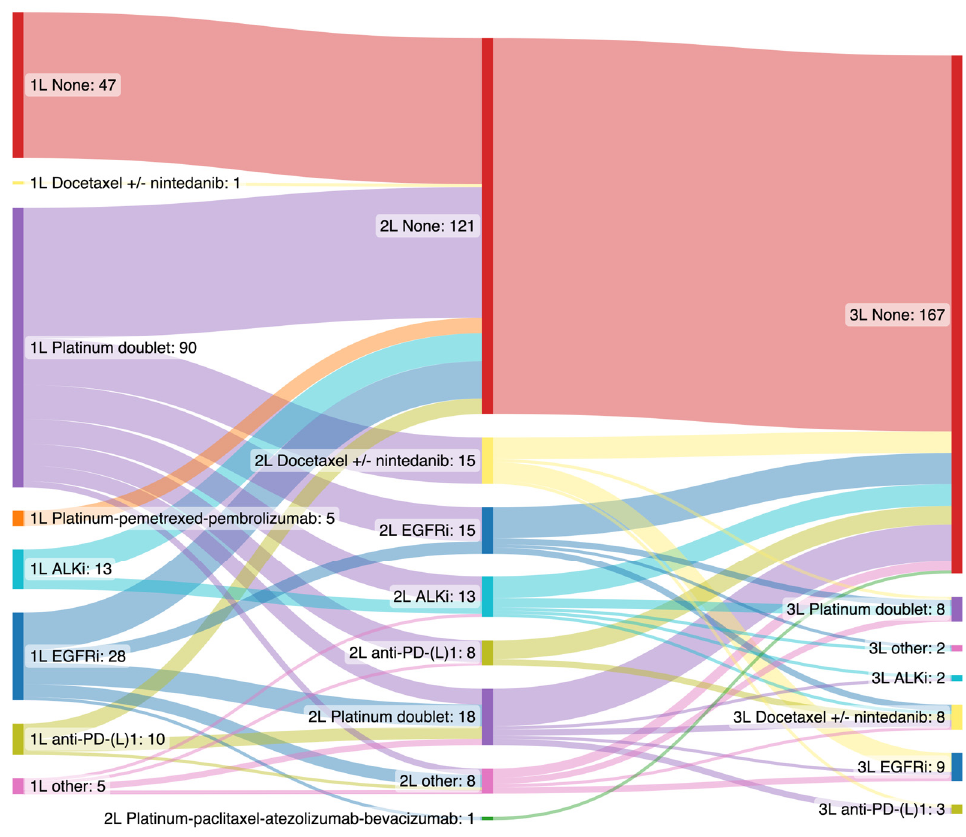
Figure 2. Systemic anti-cancer therapy (SACT) frequencies of all young metastatic NSCLC patients ( n = 199) by sequential lines of therapy (1L—first line; 2L—second line; 3L—third line; ALKi—ALK tyrosine kinase inhibitor; anti-PD-(L)1—anti-programmed cell death protein-1/programmed death- ligand 1; EGFRi—EGFR tyrosine kinase inhibitor).